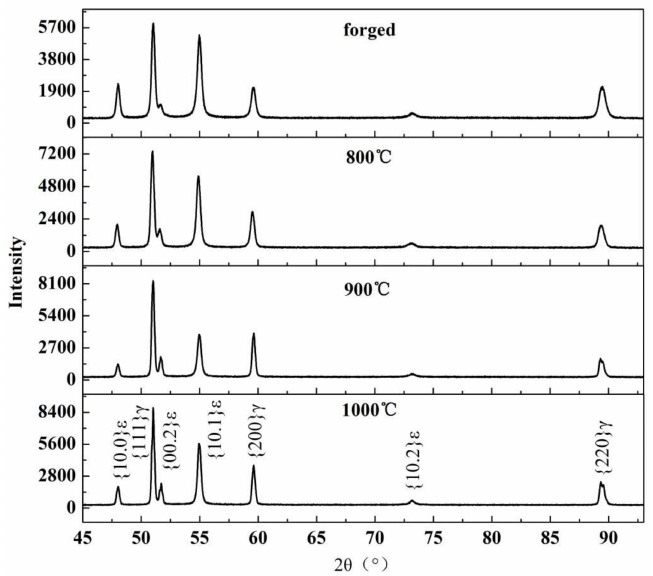
Figure 7. XRD patterns of Fe-22Mn-12Cr-4Co-0.2Nb-0.02C alloy after annealing at different